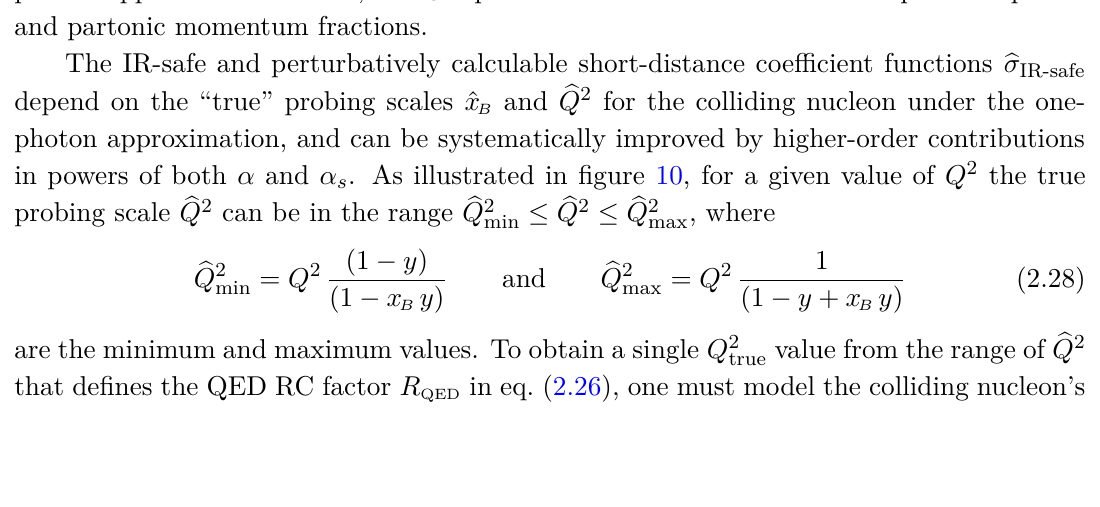
Figure 10 . The range of the hard scale b Q 2 experienced by the nucleon as a function of the measured scale Q 2 , for fixed values of x (right) kinematics. The straight black lines correspond to b Q 2 = Q 2